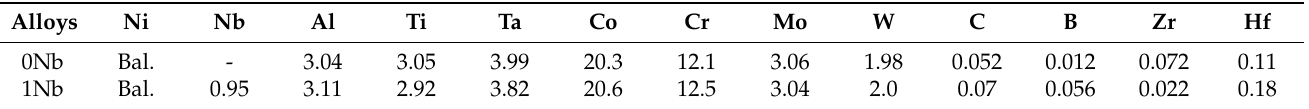
Table 1. Compositions of two alloys in weight percent (wt%) tested by inductively coupled plasma optical emission spectroscopy (ICP-OES).